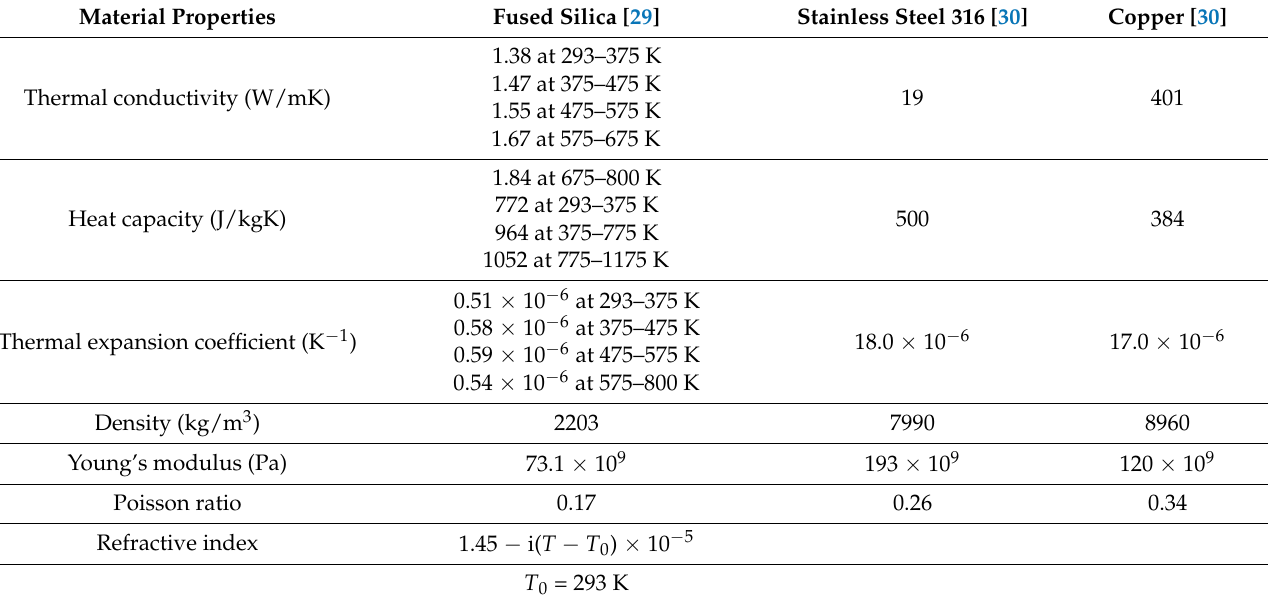
Table 1. Material properties used in the